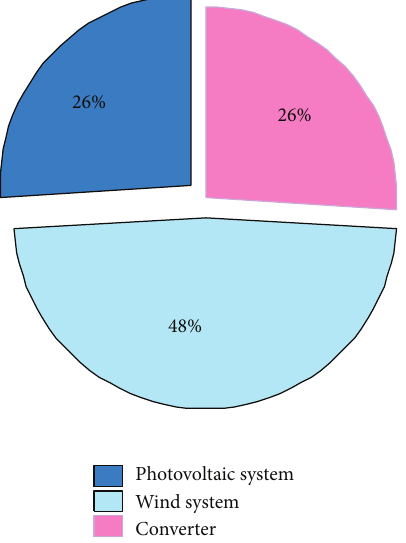
Figure 12: Distribution of operation hours of each of the renewable energy equipment of the hybrid PV-wind-Grid system.